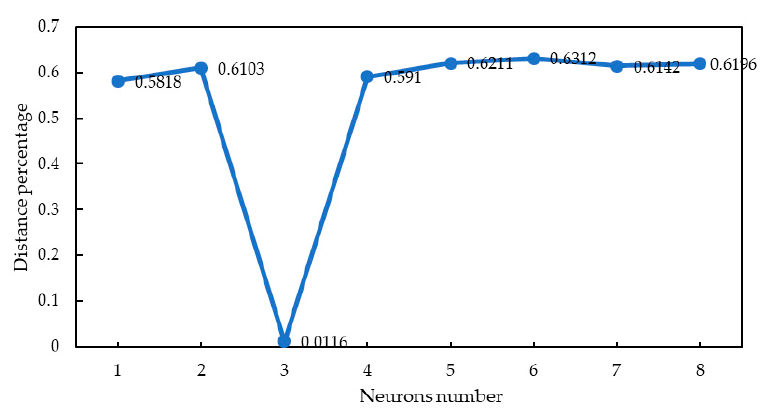
Figure 10. The distance percentage of di ff erent Dense layer number.